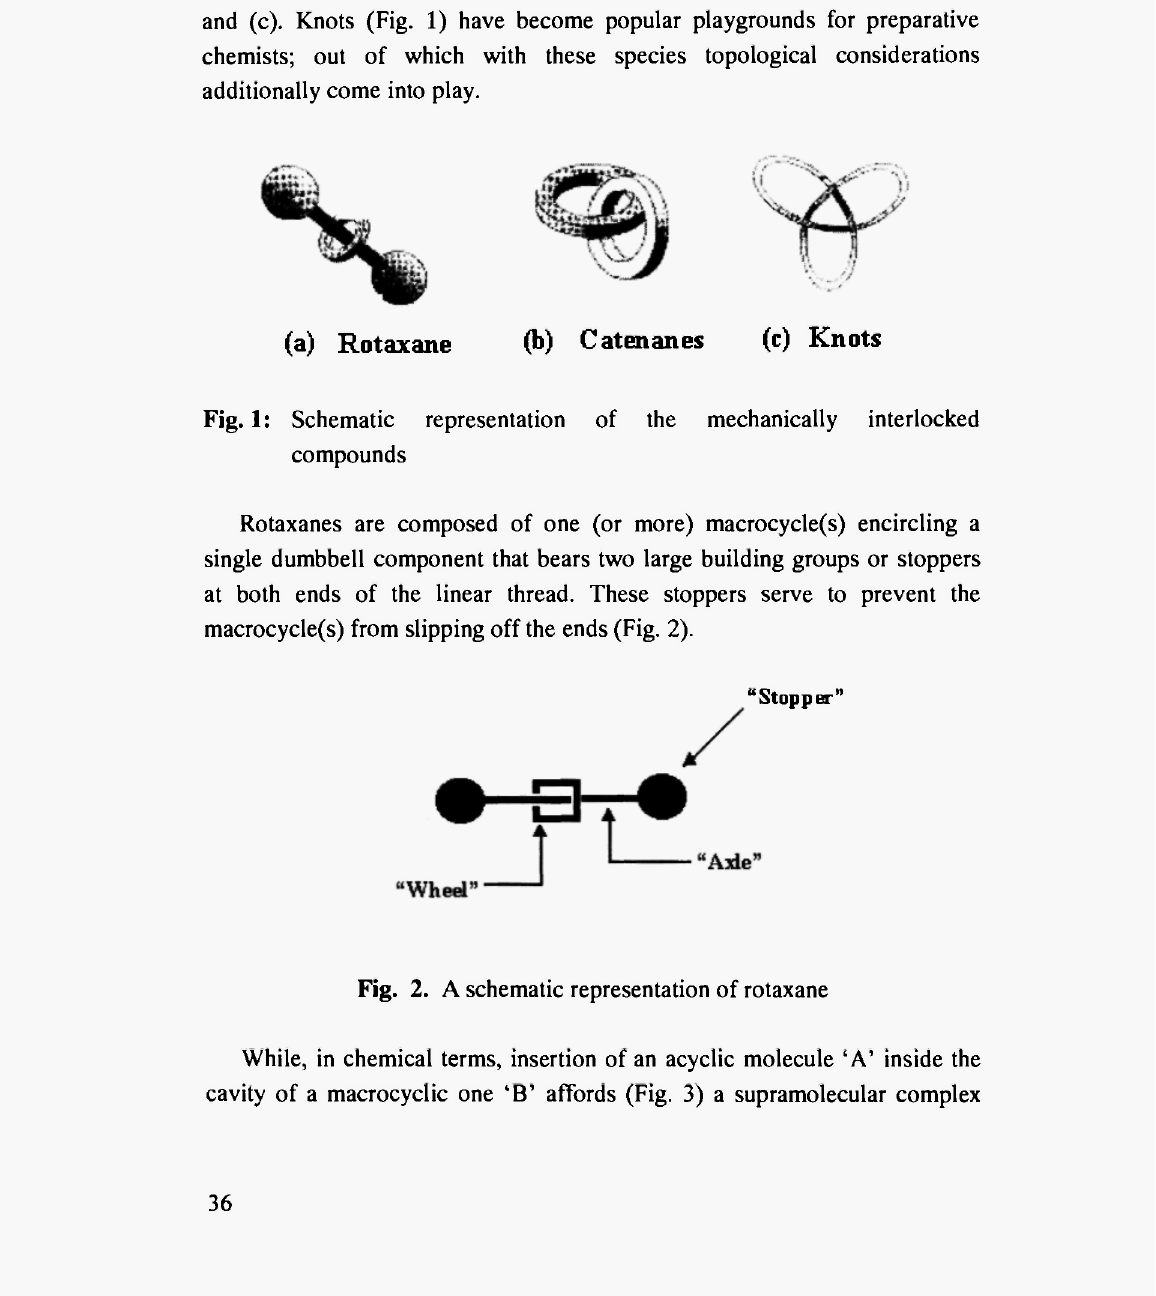
Fig. 2. A schematic representation of